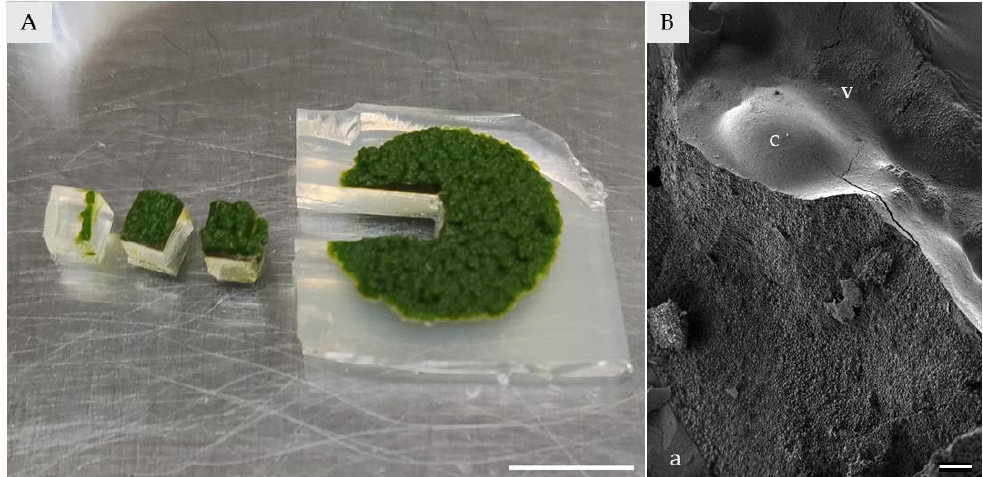
Figure 1. ( A ) Sample preparation before attaching to the cryo-holder: square-shaped samples of 2 × 2 mm of axenically cultured Trebouxia lynnae were cut, including the underlaying agar, in order to maintain the colony structure of the region to be analysed. ( B ) LTSEM of T. lynnae : general view of the cross-section of the colony, displaying the crests (c) and valleys (v) and the underlaying agar (a). Scale bar: ( A ) 100 µm, ( B ) 10 mm.